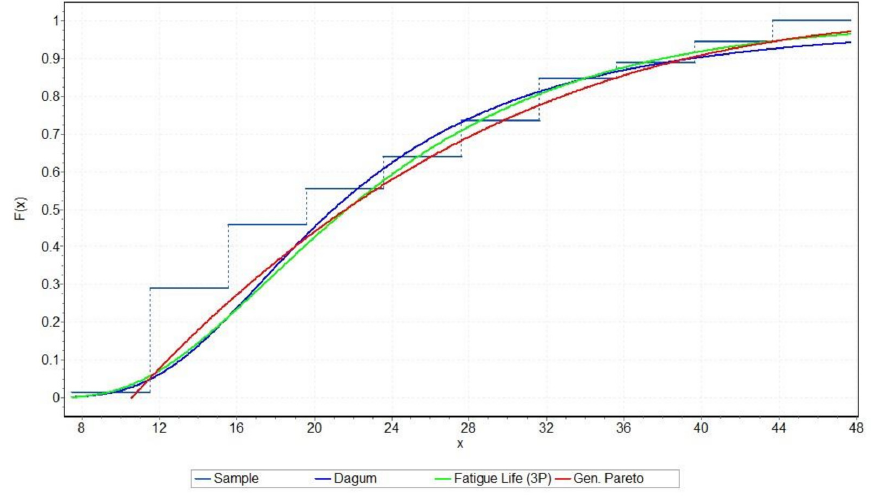
Figure 17. Empirical PDF and the three best fitted three-parameter distributions of NiTi-2 alloy corrosion rate in the sea